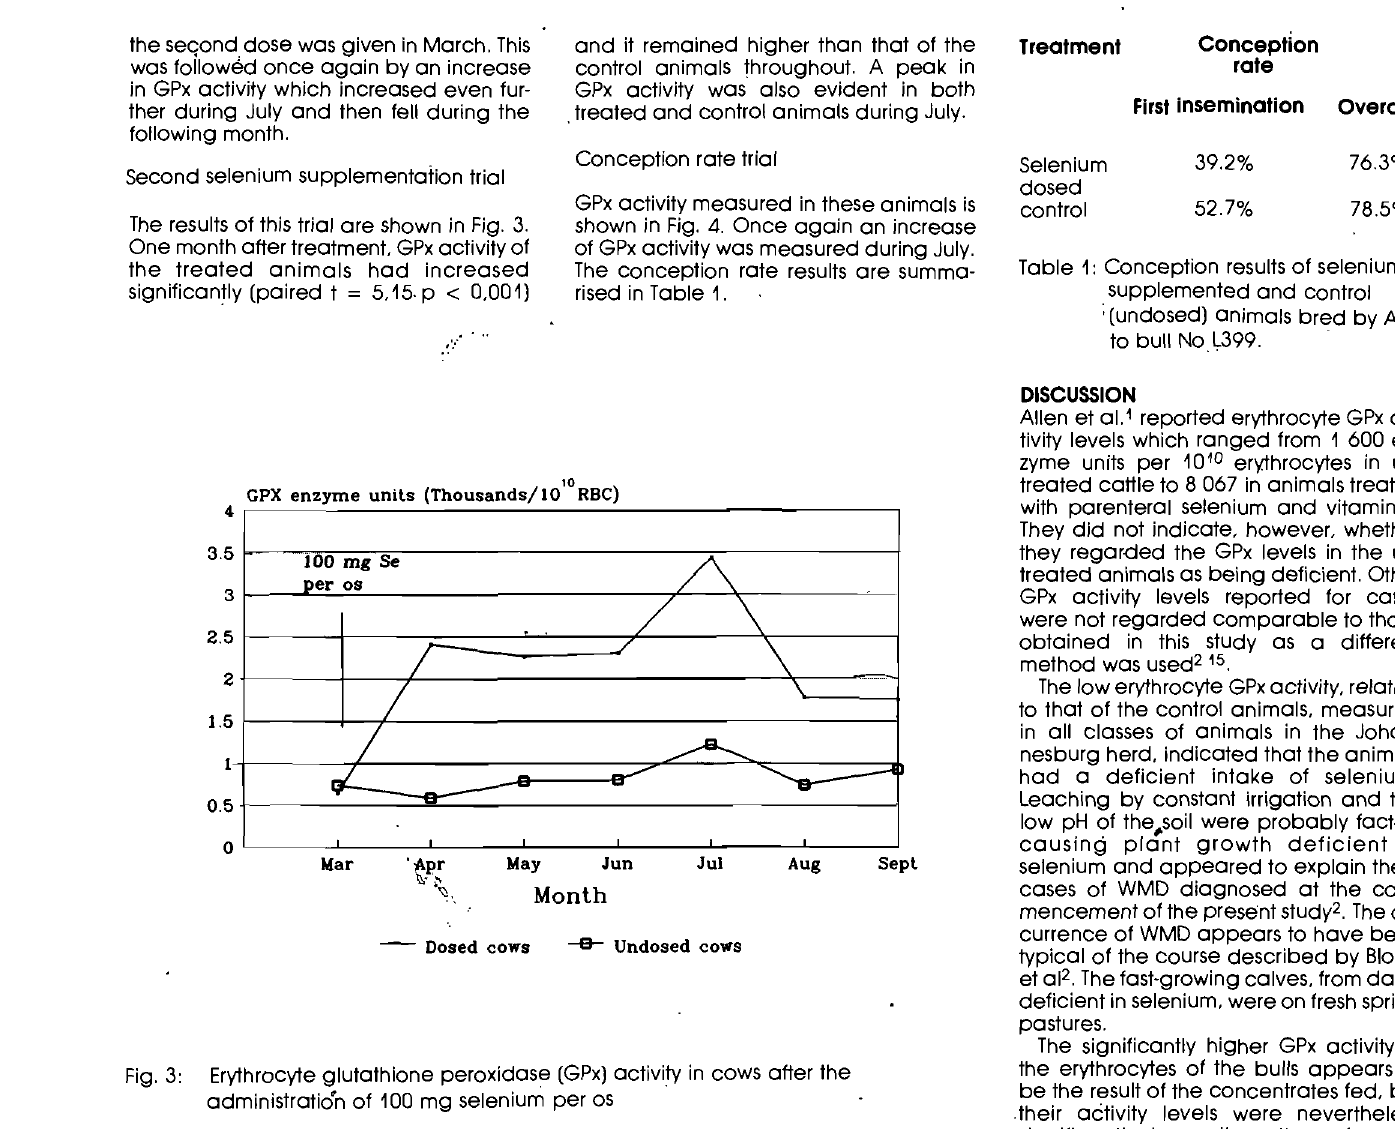
Erythrocyte glutathione peroxidase (GPx) activity in cows after the administration of 100 mg selenium per os